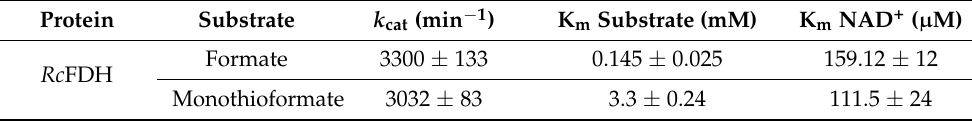
Table 3. Kinetic parameters for the steady state kinetics of R. capsulatus FDH for formate and monothioformate as substrates (see also Figure 3).